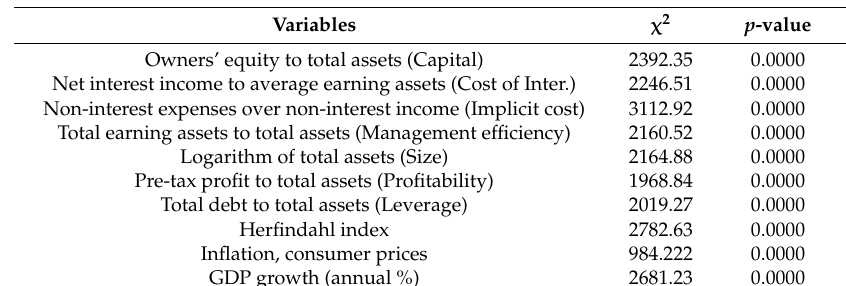
Table A1. Test of Non-Stationary.